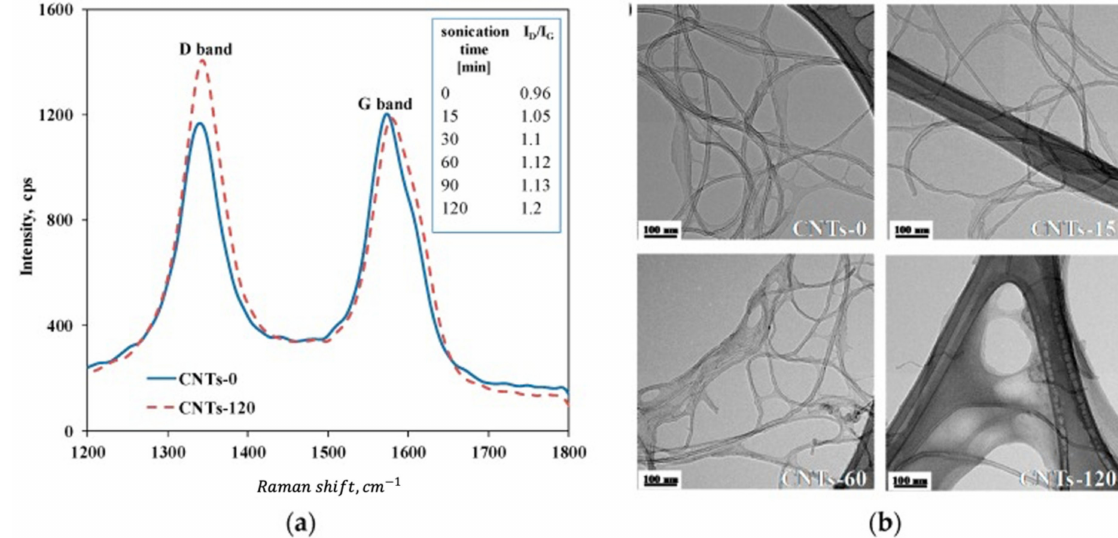
Figure 7. Effect of ultrasonication on surface changes of CNT, cited from [70]: ( a ) shift of D-band to G-band during ultrasonication process, representing the concentration of defect site content on the CNT structures; ( b ) TEM images showing alterations of ultrasonic-treated CNT compared to untreated ones.